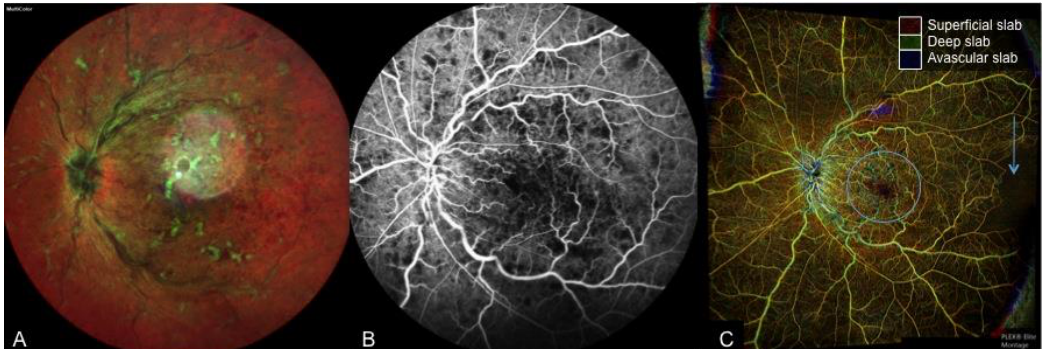
Figure 6. A case of central retinal vein occlusion. ( A ): Multi-color fundus photograph depicting tortuous venous segments, dot, blot, and flame hemorrhages and cotton wool spots. ( B ): FA depicting dilated and tortuous retina veins with patchy areas blocked by retina hemorrhage. ( C ): color-coded depth-resolved en face OCTA, which is a fusion image of the superficial (red), deep (green), and avascular (blue) en face OCTA slabs. An enlarged fovea avascular zone (blue circle) and temporal loss of flow (blue arrow), which is not depicted on FA, is seen on